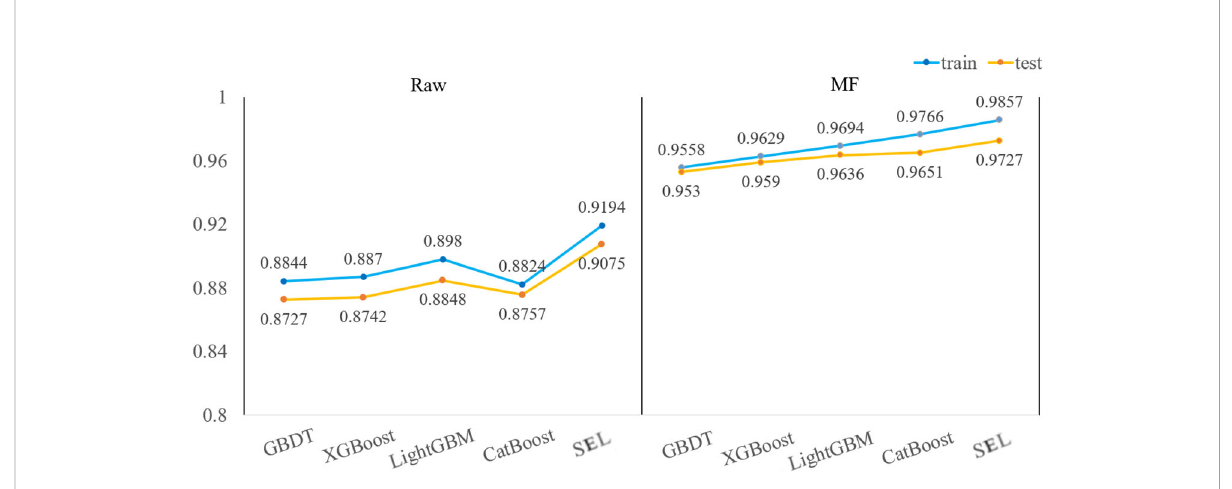
FIGURE 6 The training set and test set accuracy of the original hyperspectral data and the MF preprocessed hyperspectral data as input for the fi ve